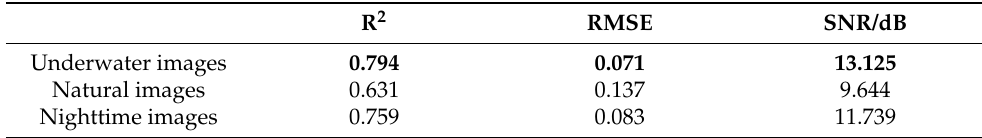
Table 2. The restored effect of images (the noise is 10